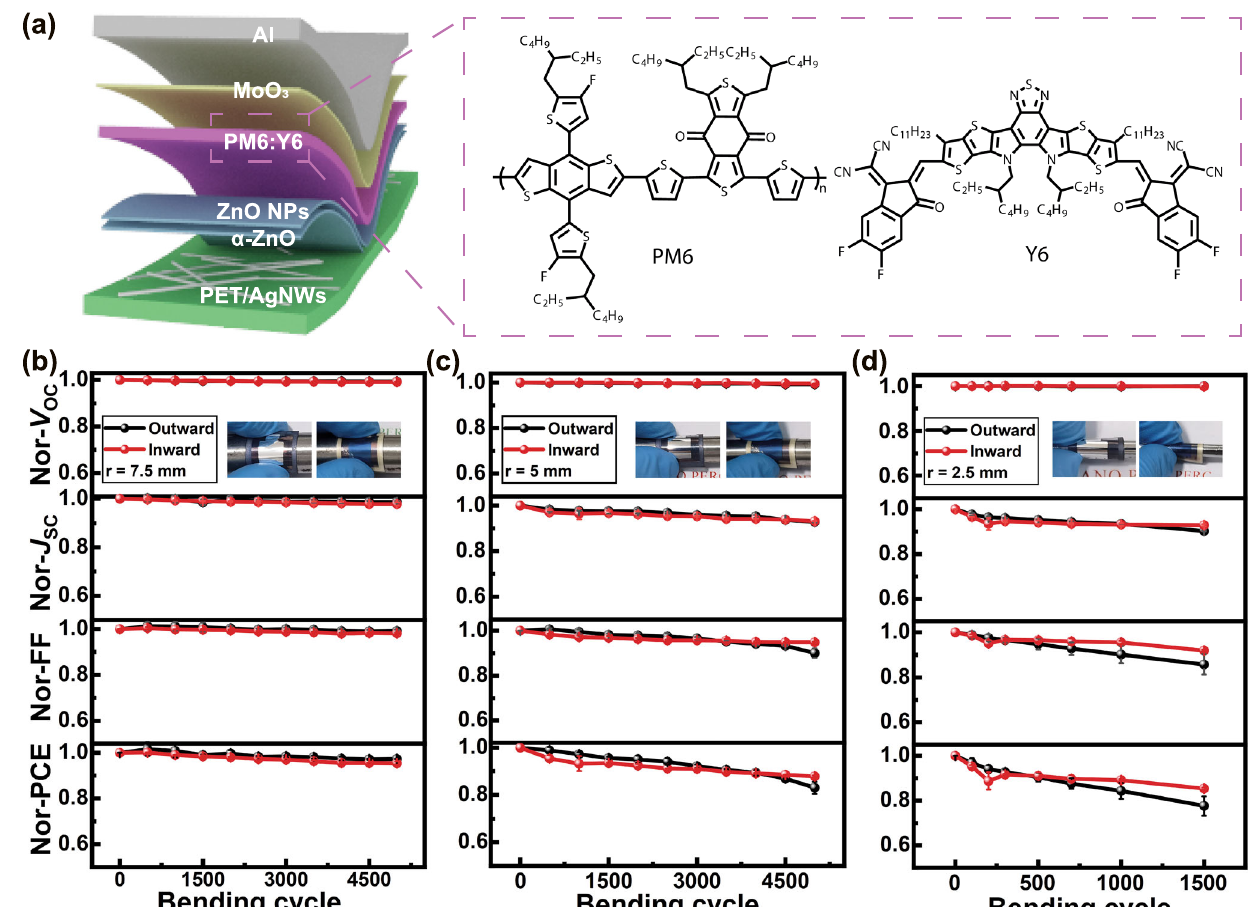
Fig. 1 Bending durability of inverted FOSCs. a Device structure and molecular structures of PM6 and Y6. Evolution of V OC , J SC , FF, and PCE of the FOSCs during continuous bending in inward and outward direction with bending radii of b 7.5, c 5.0, and d 2.5